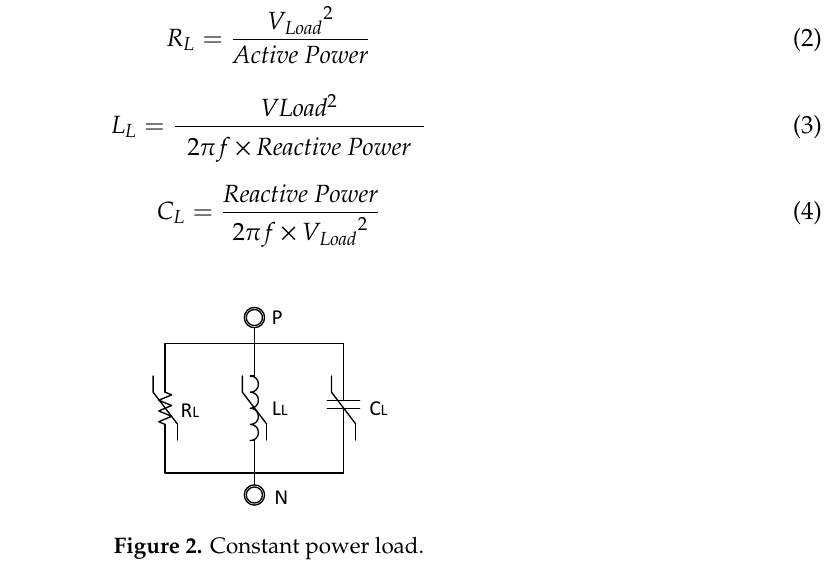
Figure 1. Single line diagram of the CIGRE underground residential low-voltage (LV) distribution network with photovoltaics (PV).